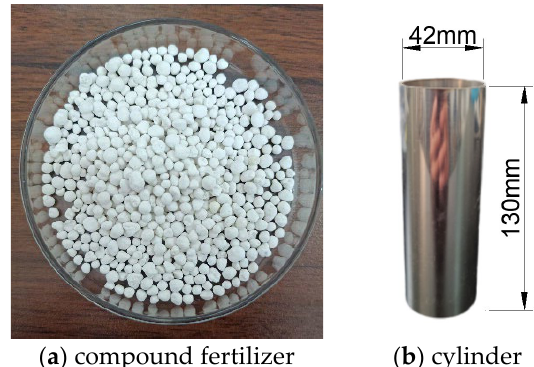
Figure 1. Test materials ( a , b ).